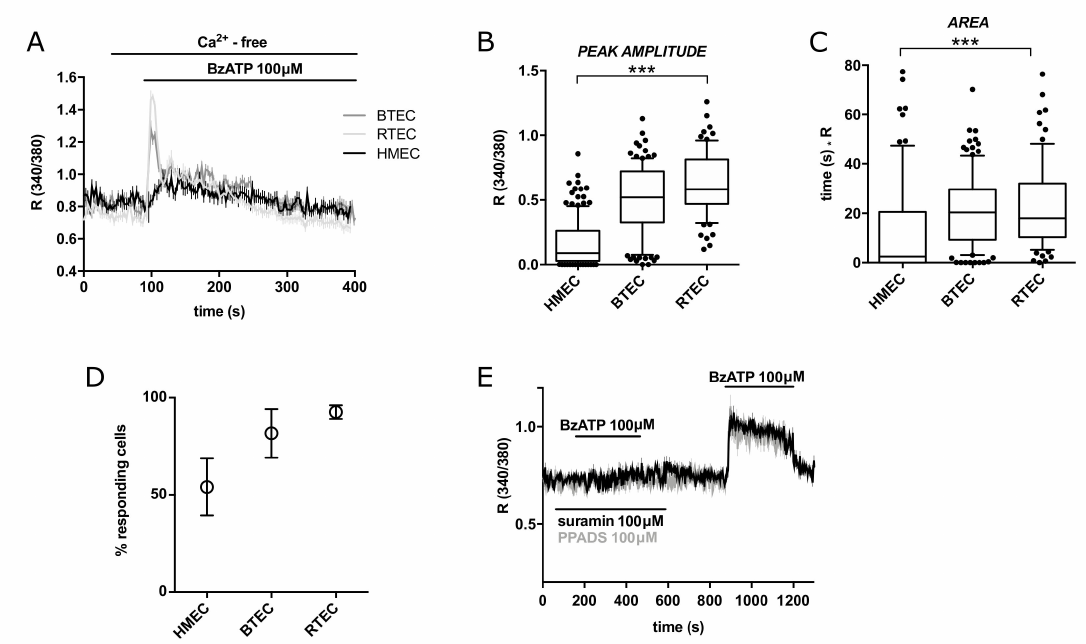
Figure 3. ( A ) Representative traces of 100 µ M BzATP-induced calcium signals in HMEC, BTEC